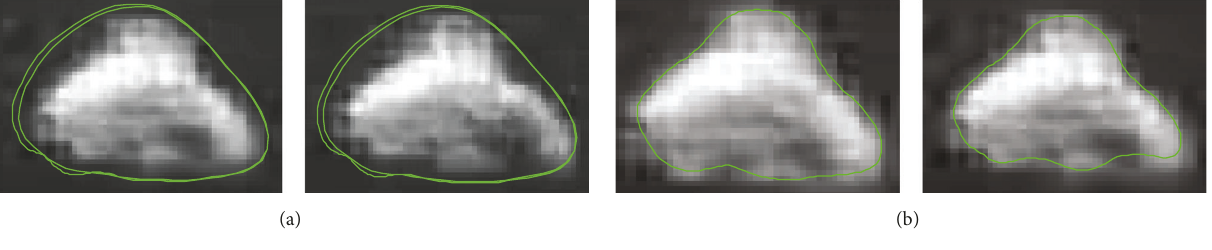
Figure 10: The enlarged results for clear comparison.